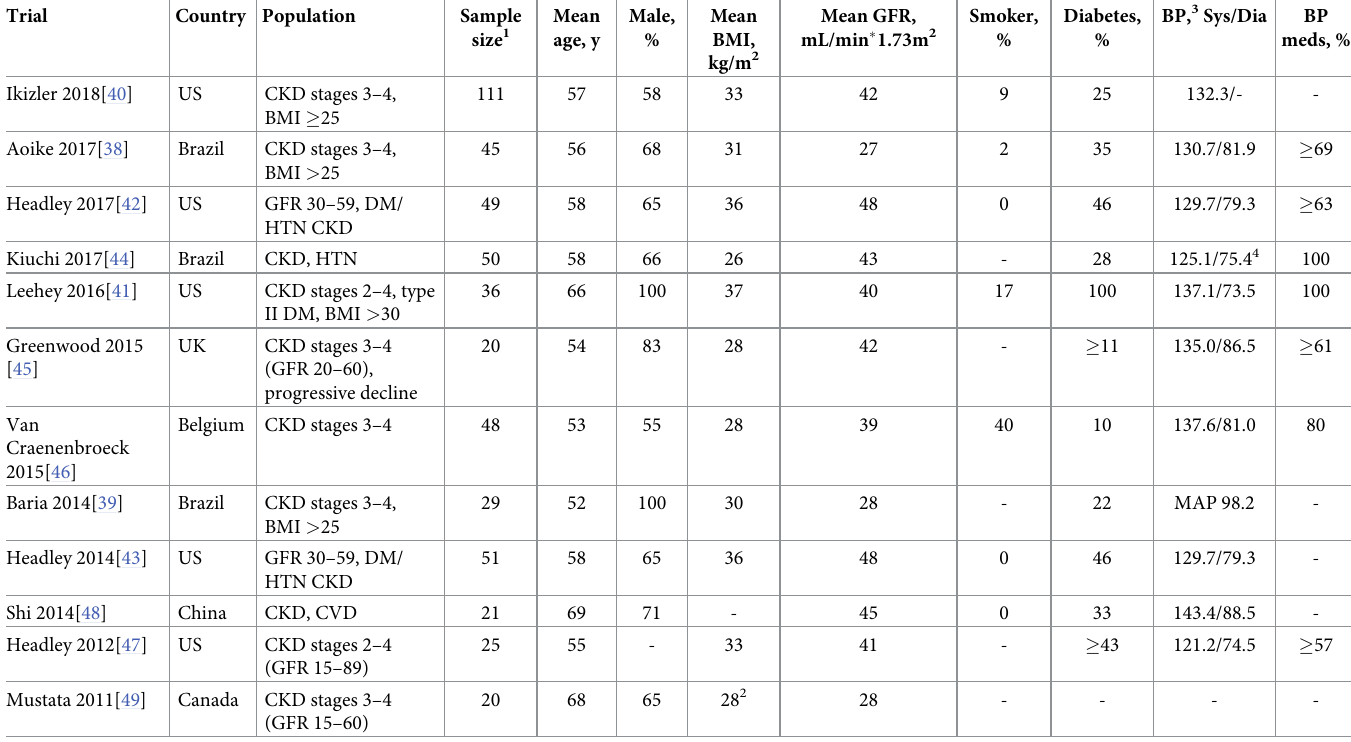
Table 1. Population characteristics of included